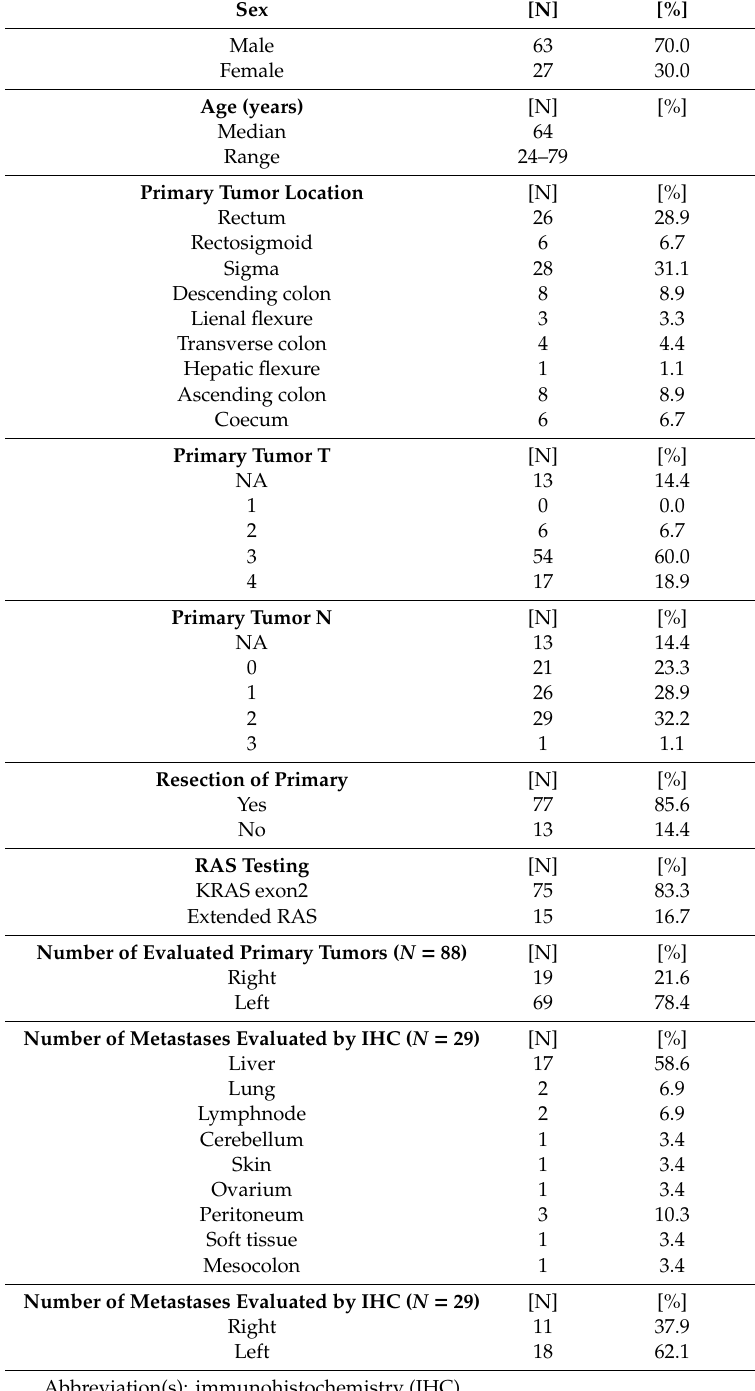
Table 1. Cetuximab-treated patient’s characteristics ( N =